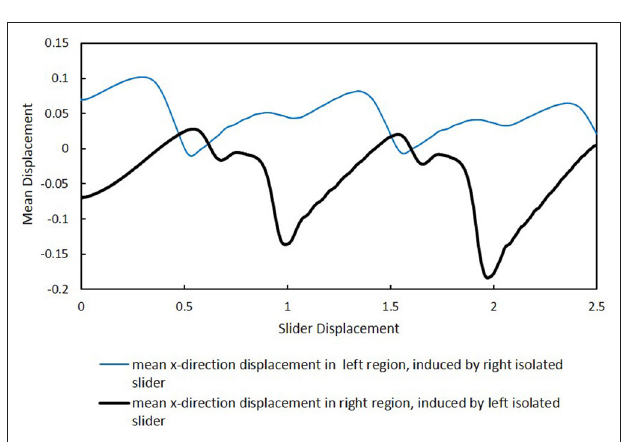
FIGURE 12 | Comparison of mean displacements induced in opposite region by isolated